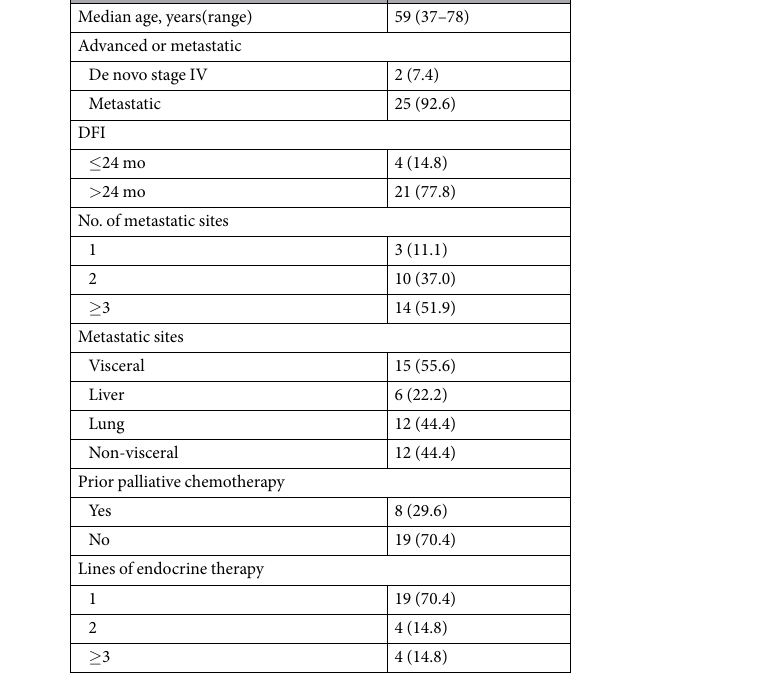
Table 1. Patient